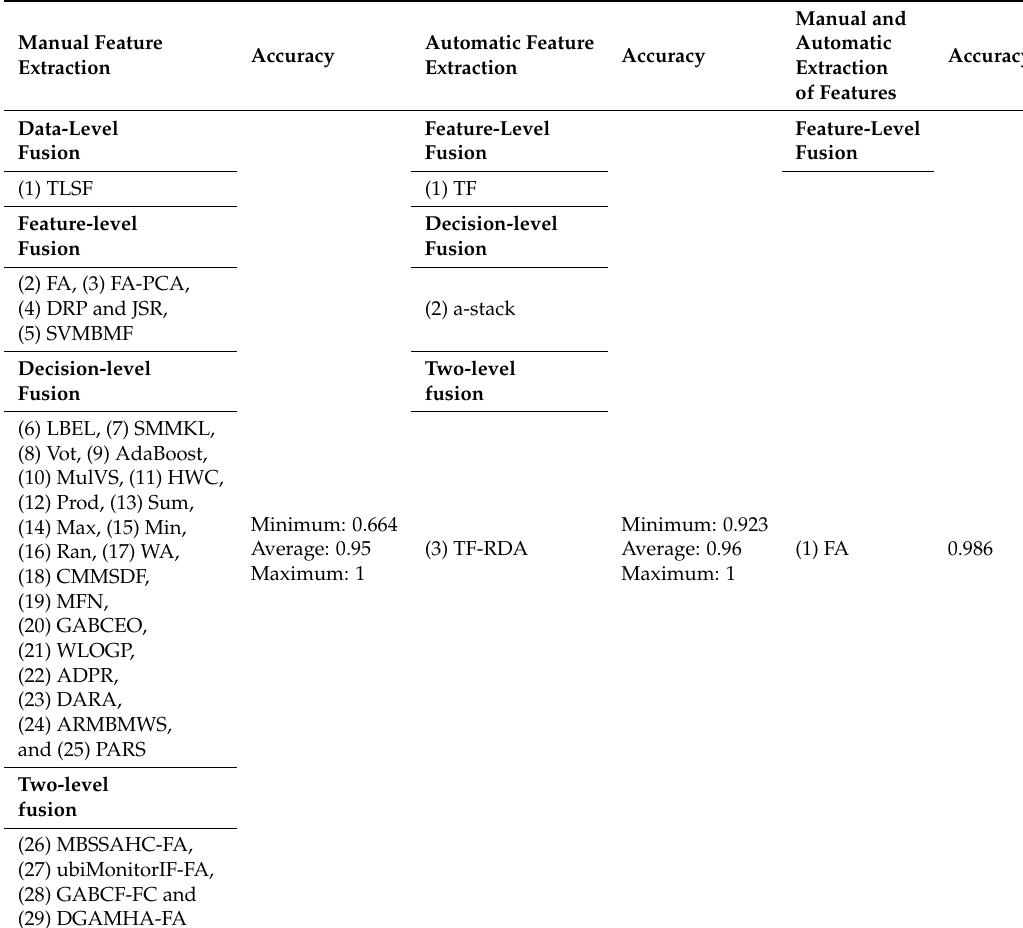
Table 7. The minimum, average and maximum accuracy reached by the group “Manual feature extraction,” by the group “Automatic feature extraction,” and by the group “Manual and